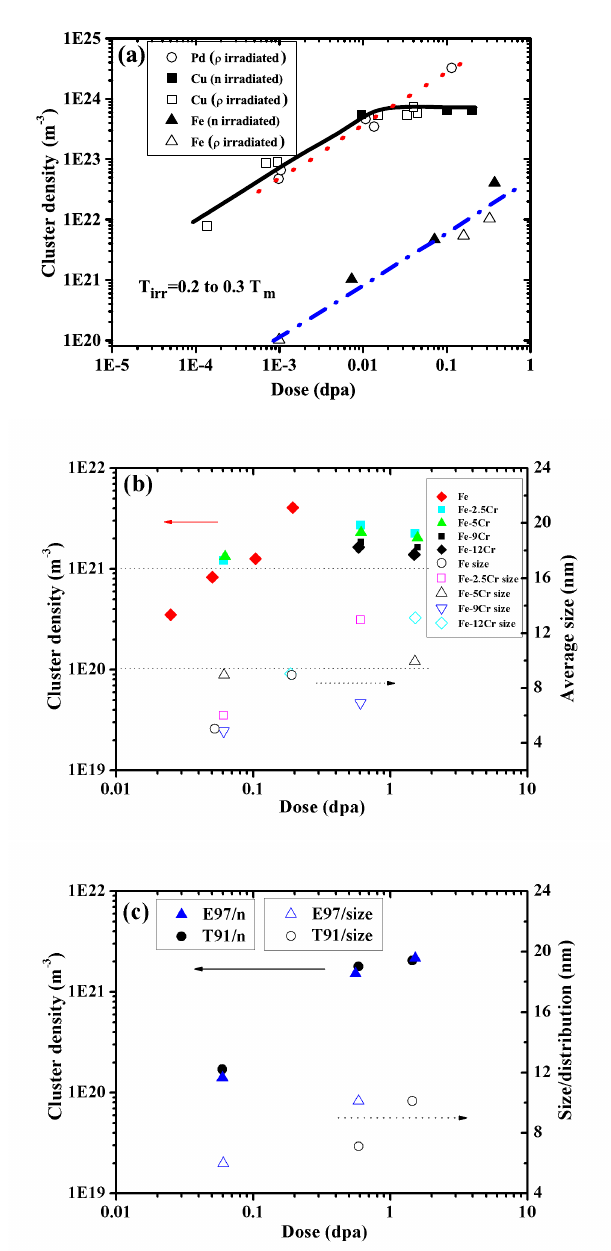
Figure 2. (color online) Dose dependence of cluster density and size distribution under neutron or proton irradiation. ( a ) Cu, Pd and Fe. (Reprinted with permission from [60]. Copyright 2000 by Elsevier.) ( b ) Fe and Fe-Cr alloys. (Reprinted with permission from [61]. Copyright 2008 by Elsevier.) ( c ) T91 and EUROFER97 steels. (Reprinted with permission from [75]. Copyright 2008 by